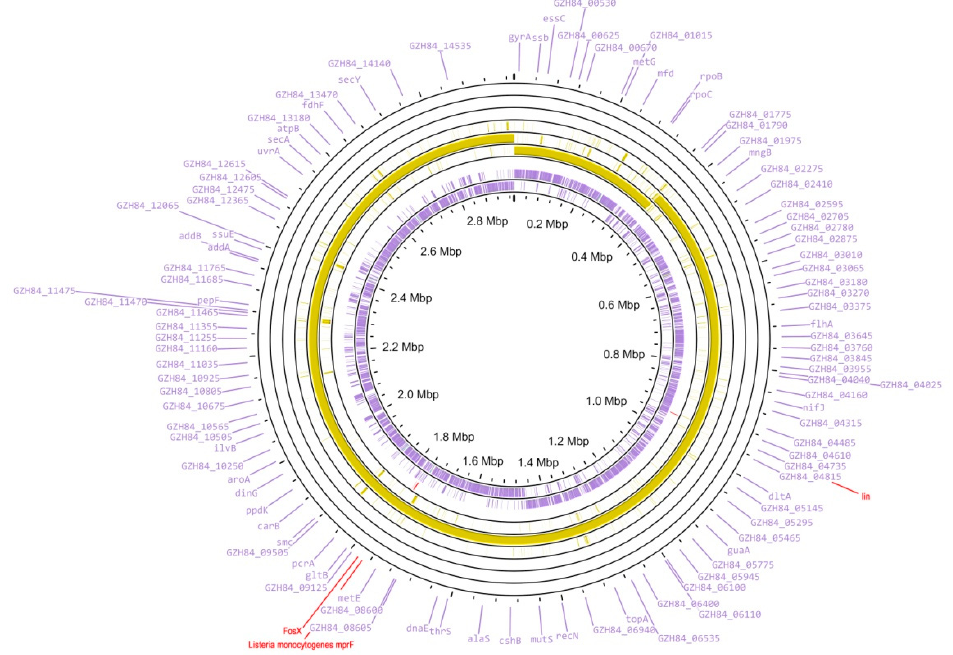
Figure 1. Circular representation of the genome for L. monocytogenes strain 4/52-1953. The two circles inside (the purple diagram) show the distribution of the positions for protein-coding genes. The short, red dashed lines in next cycle show the position of ARM genes which were detected using the predic- tive algorithm CARD RGI (https://card.mcmaster.ca/, accessed on 29 May 2022). The next circles with yellow diagram demonstrate the positions of BLAST hits determined through BLAST comparison of L. monocytogenes strain 4/52-1953 with the closest homologous strain L. monocytogenes M7. The regions of the genomes of these two strains with 99% homology are marked with a solid yellow line. The re- gions with low homology (lower than 80%) of the genome of L. monocytogenes strain M7 vs. L. mono- cytogenes strain 4/52-1953 are indicated by short, yellow dashed lines. The figure was generated using the Proksee online tool (https://proksee.ca/, accessed on 29 May 2022). 4/52-1953 and other L. monocytogenes, we used whole genomes of all the L. monocytogenes strains ( n = 256) available in the NCBI GenBank (https://www.ncbi.nlm.nih.gov/, accessed